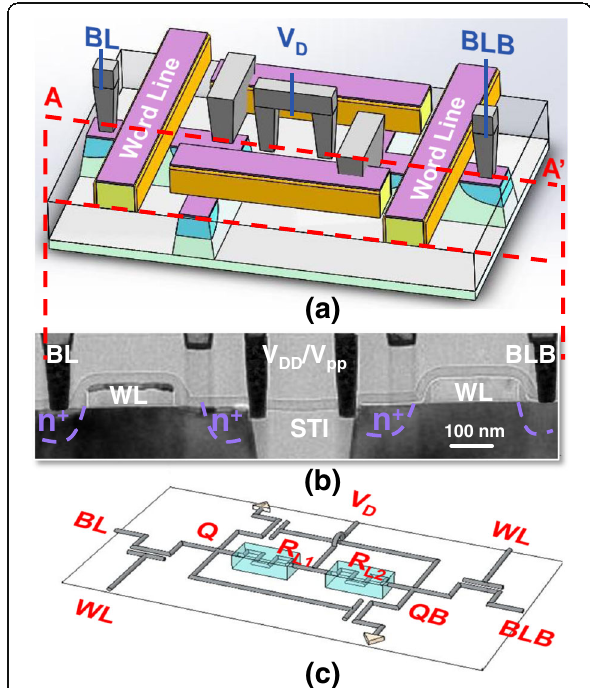
Fig. 5 a 3D illustration of the proposed 4T2R nv-SRAM cell structure and the b corresponding cross-sectional TEM picture. c The circuit schematic of a SRAM cell is shown with two RRAM resistors as the loading